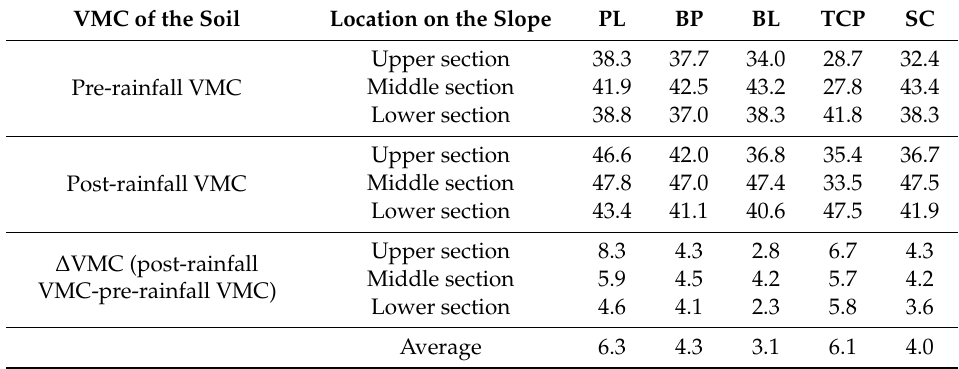
Table 4. Variations of VWC in di ff erent slope positions before and after rainfall VMC of the Soil Location on the Slope PL BP BL TCP